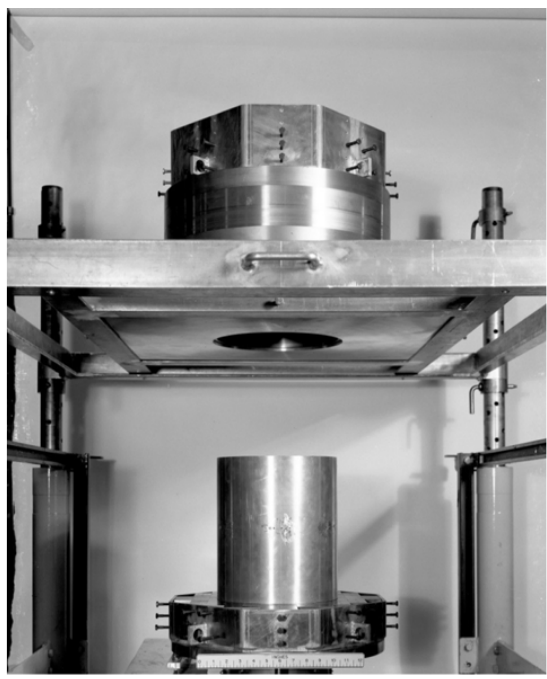
Figure 3. ORNL beryllium-reflected space reactor